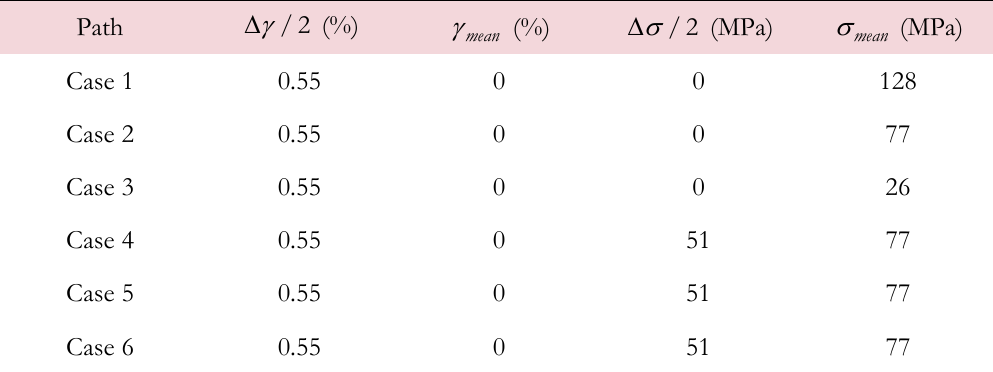
Table 1: Multiaxial ratcheting testing of 316L wire under various loading paths